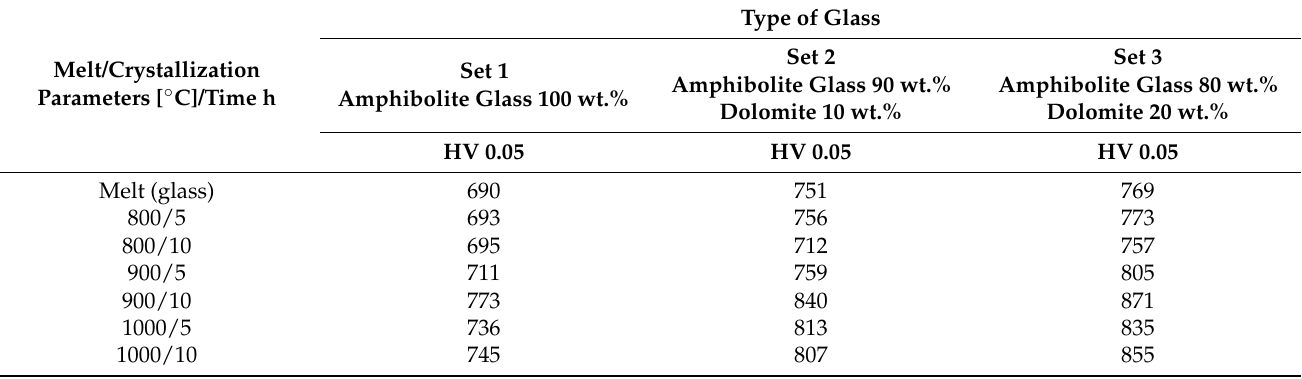
Table 5. Vickers microhardness results for amphibolite glasses after melting and the crystallization